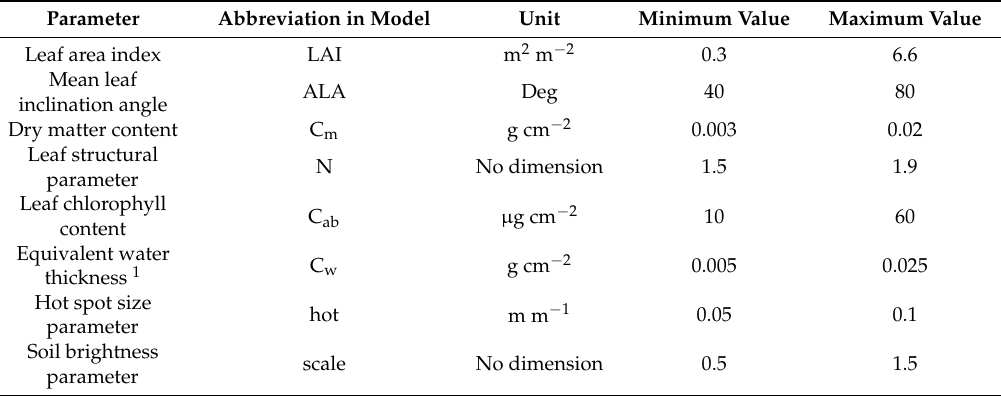
Table 2. Specific ranges for model input parameters used for generation of RapidEye and Sentinel-2 look-up tables (LUTs) using the PROSAIL model. The parameters values were selected randomly (uniform distributions) within the specified